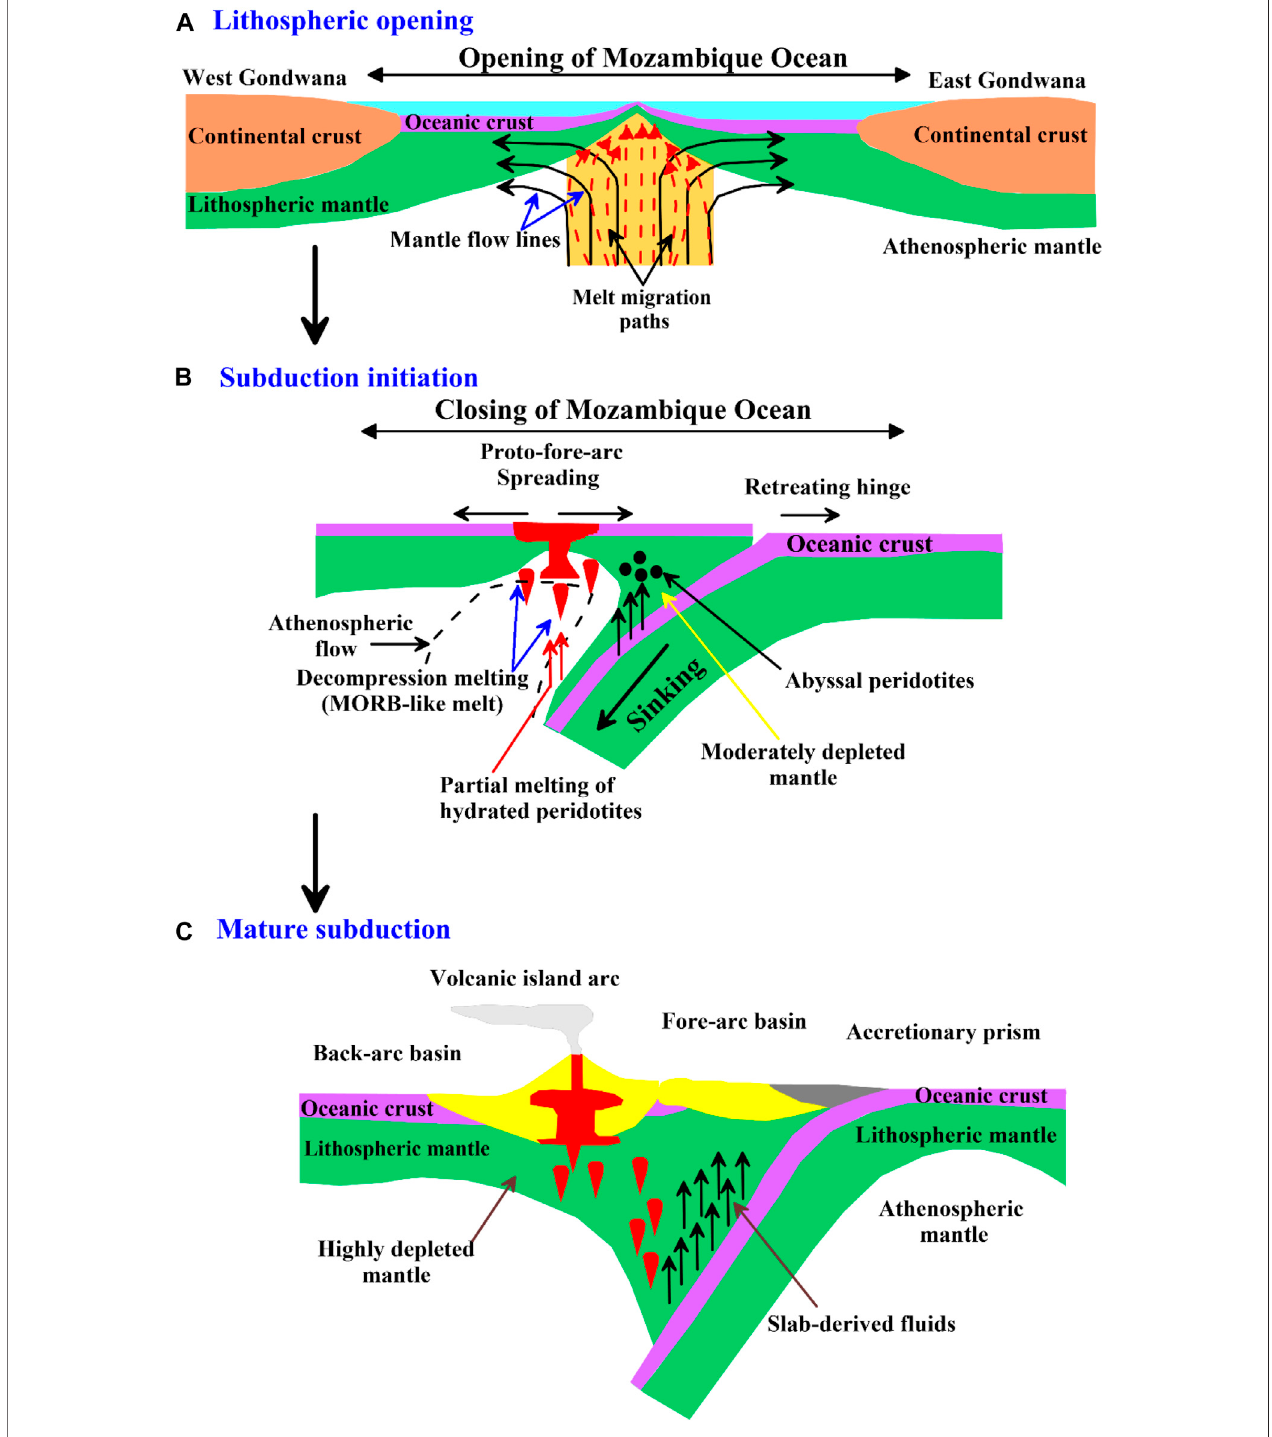
FIGURE 19 | Schematic illustration showing the tectonic model for the evolution of the studied ultrama fi c rocks and the Arabian – Nubian Shield. The carton was designed after a sketch by Whattam and Stern (2011), Moghadam et al. (2015), Khedr and Arai (2016), Gamal El Dien et al. (2016), and Abdel-Karim et al. (2021). (A) OpeningofMozambicanoceanbetweenEastandWestGondwana; (B) subductioninitiationorincipientarcstage,inwhichpartialmeltingoccurredinthemantlewedge and the proto-forearc spreading starts to form over the subduction zone; the serpentinites and pyroxenites of Wadi Al-Qulieb were formed in this stage; and (C) developmentofmaturesubductionoramature-arcstagewhichisassociatedwithtremendousslab-derived fl uidsandhighlypartialmeltingofdepletedmantleproduces peridotite serpentinite melts.